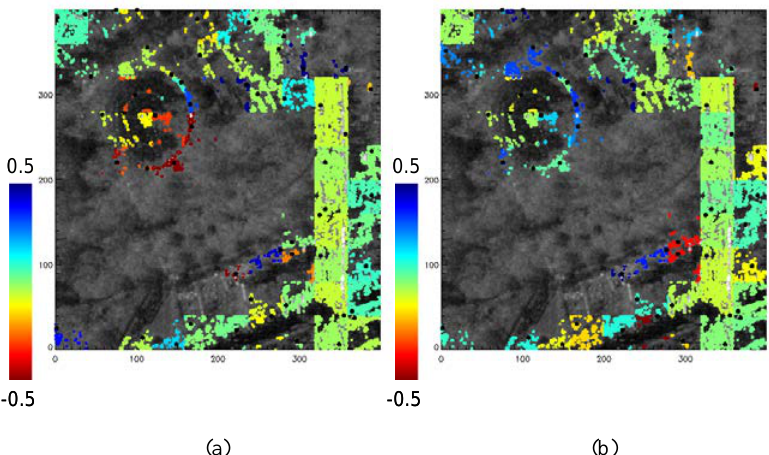
Figure 5: Deformation estimation results using the newly developed technique. (a) Estimates of local tilts of deformation velocity in range (x) direction in mm/year/pixel. (b) Estimates of local tilts of deformation velocity in azimuth (y) direction in mm/year/pixel.